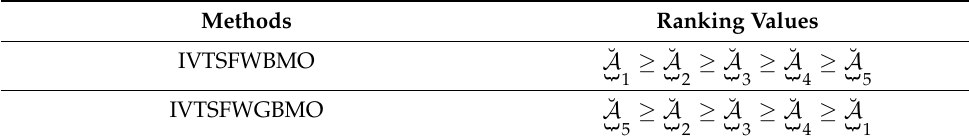
Table 7. Ranking values of the score values in Table 6.